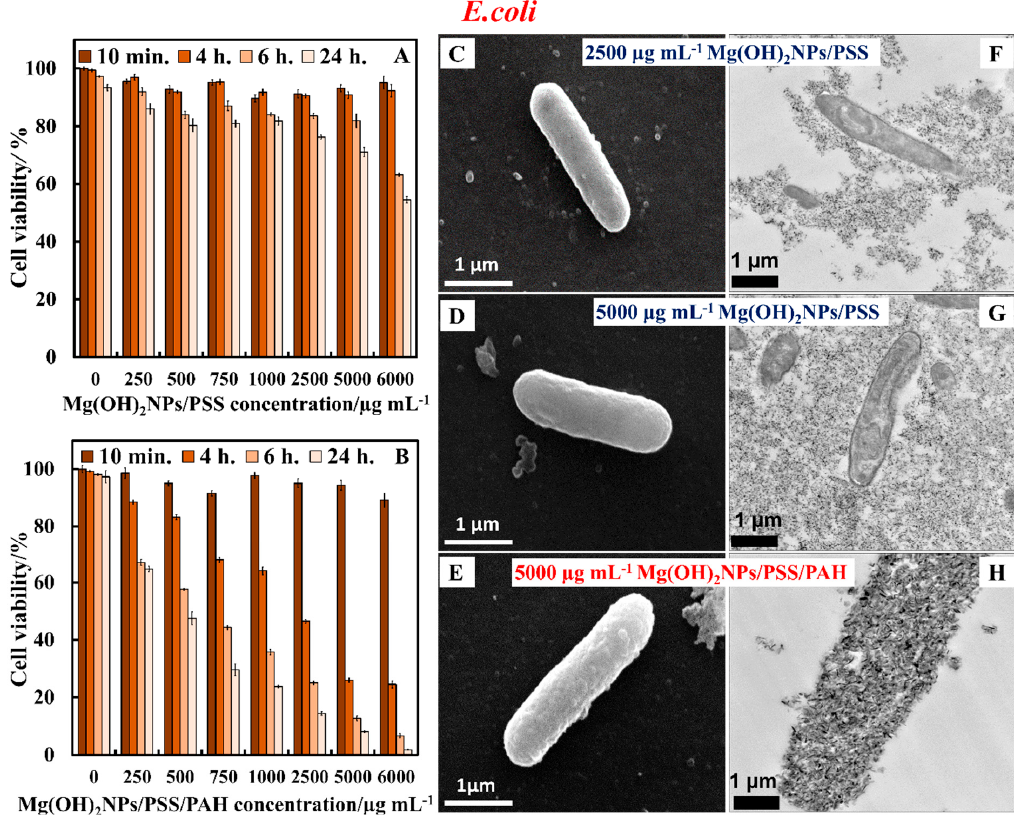
Figure 11. The E. coli cell viability after treatment with ( A ) Mg(OH) 2 NPs / PSS and ( B ) Mg(OH) 2 NPs / PSS / PAH for various incubation times as a function of the NPs concentration. ( C ) SEM and ( F ) TEM images of E. coli after incubation with 2500 µ g mL − 1 Mg(OH) 2 NPs / PSS; ( D ) SEM and ( G ) TEM images of E. coli after incubation with 5000 µ g mL − 1 Mg(OH) 2 NPs / PSS; ( E ) SEM and ( H ) TEM images of E. coli after incubation with 5000 µ g mL − 1 Mg(OH) 2 NPs / PSS / PAH. The cells were removed from the particle suspension before the sample preparation for TEM and SEM